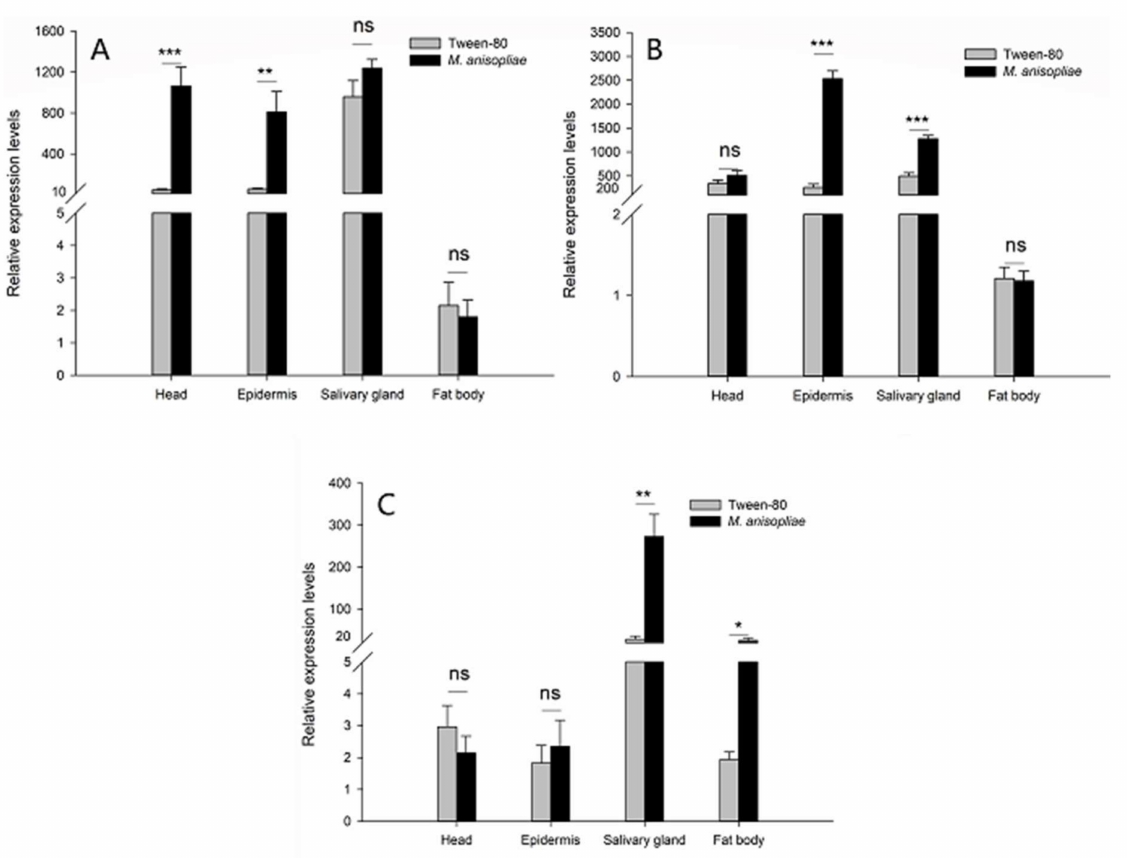
Figure5. Analysisoftheexpressionlevels of( A ) RfARSB-0311 , ( B ) RfARSB-11581 , and( C ) RfARSB-14322 in the head, epidermis, salivary gland, and fat body after immune challenge with Metarhizium anisopliae . Expression levels were normalized to the GAPDH reference gene. Data are shown as the mean ± SE from five independent biological repetitions. The asterisks marking the Student’s t test results indicate that there is a significant di ff erence between the two treatments (*, p < 0.05; **, p < 0.01; ***, p < 0.001), while “ns” indicates that there is no significant di ff erence between the control and treatment